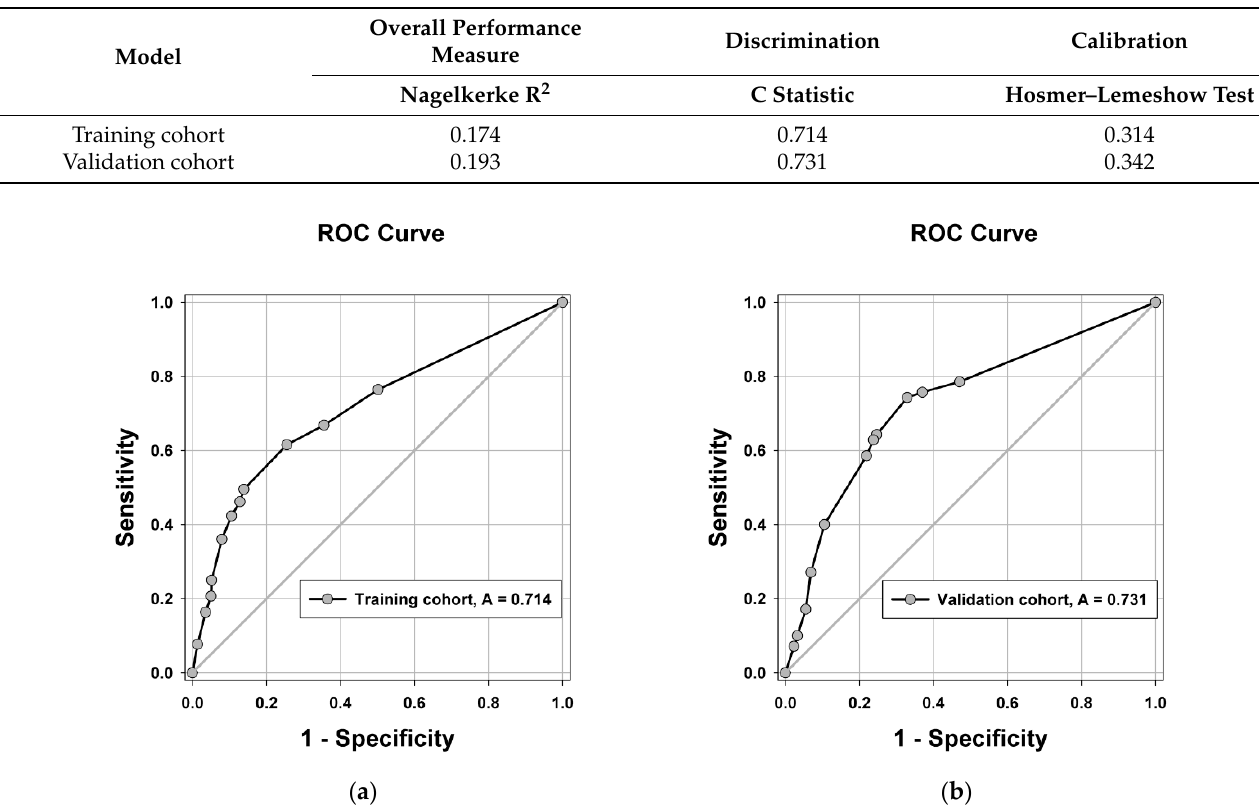
Figure 3. Receiver operating characteristic (ROC) curve of the risk score model for the prediction of microvascular invasion in ( a ) a training dataset with an area under the curve (AUC) of 0.714 and ( b ) a validation dataset with an AUC of 0.731.